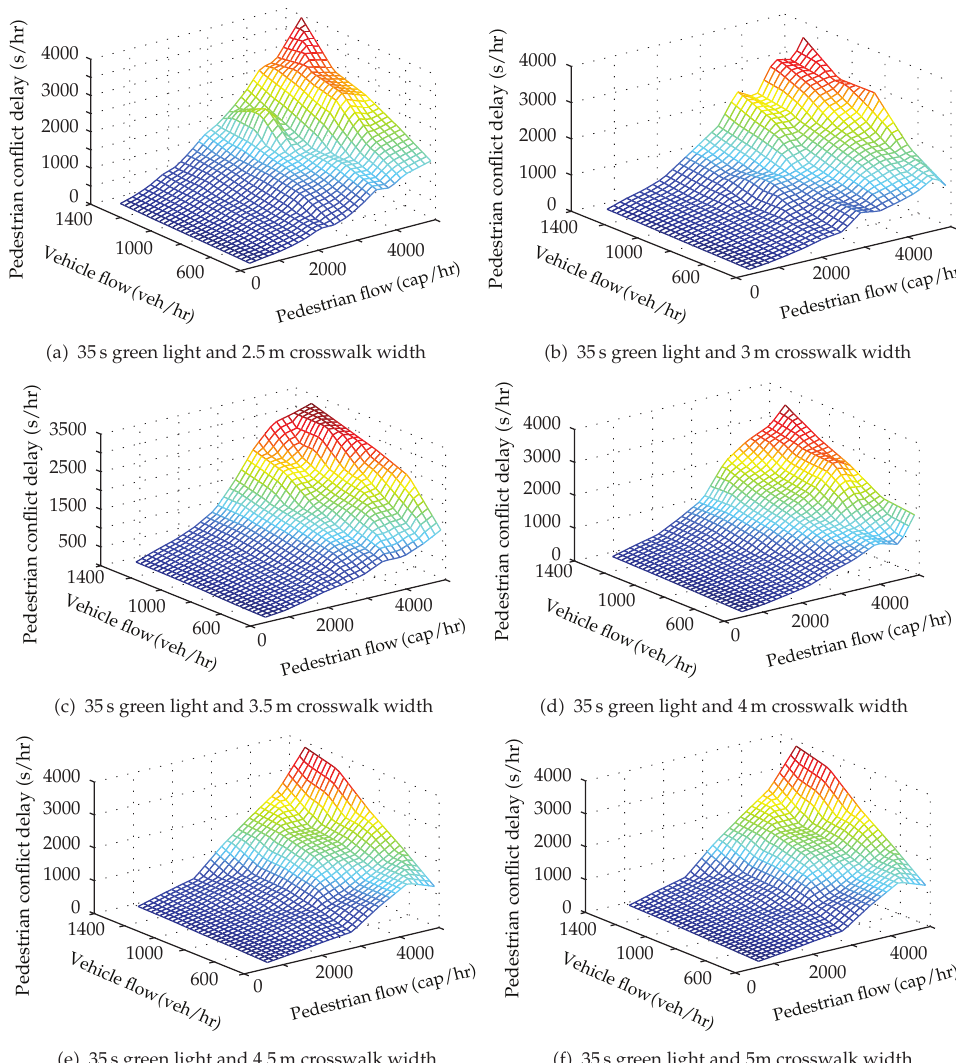
Figure 8: Relationship among pedestrian flow, vehicle flow, and pedestrian conflict delay for di ff erent types of crosswalk